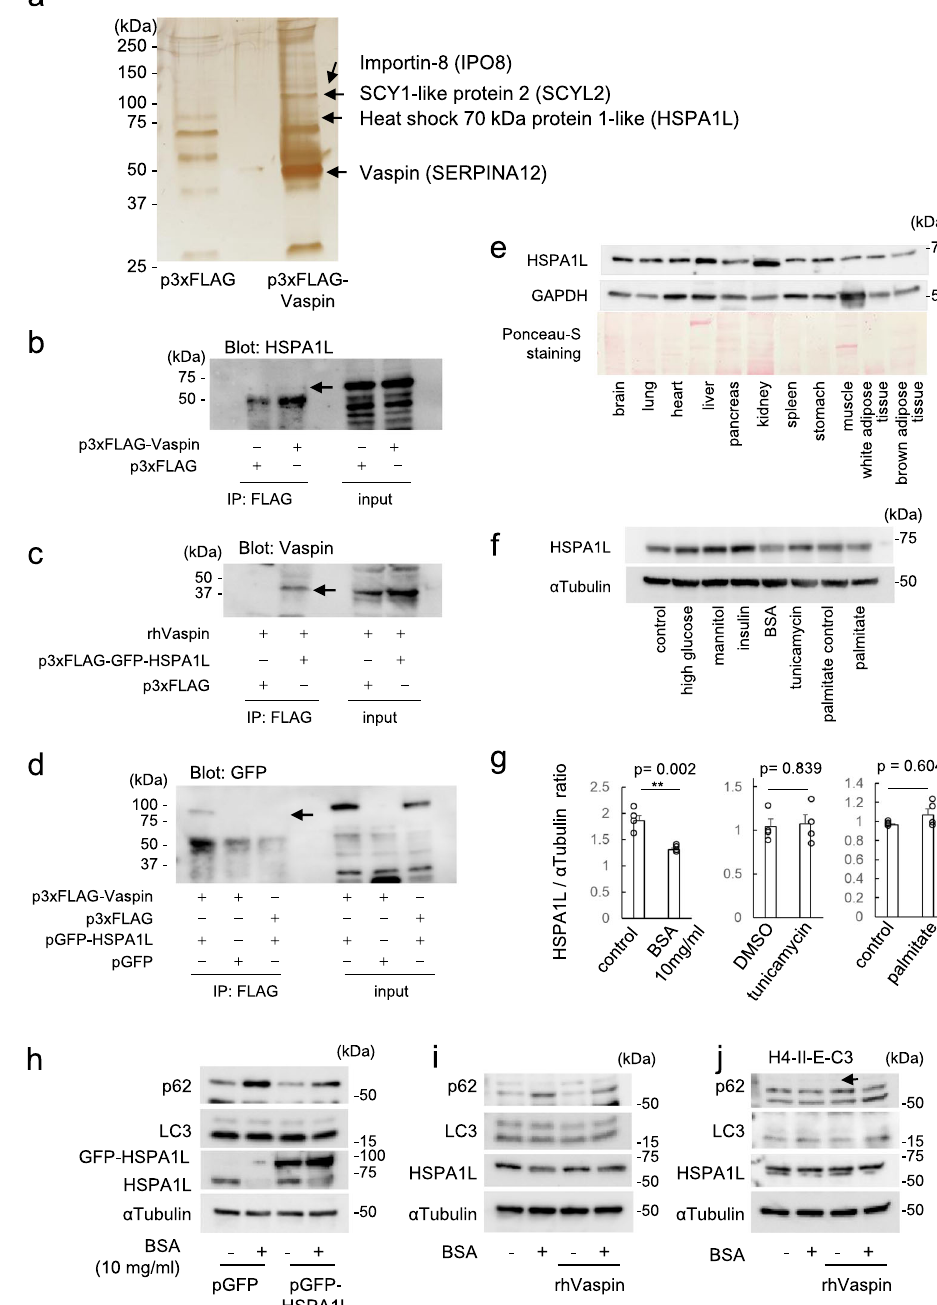
Enlarged lysosomes of proximal tubular cells in humans with obesity and diabetes mellitus . In human renal biopsy samples from diabetic nephropathy patients, enlarged lysosomes were visible by immuno fl uorescence staining of lamp1 (Supplementary Fig. S9a – c), while a patient with thin basement membrane disease (TBMD) as a nondiabetic and non-obese control demonstrated lamp1-positive lysosome as small dots (Supplementary Fig. S9d). In an overweight patient with TBMD of body mass index (BMI) 26.7 kg/m 2 , lamp1 positive vacuole were observed in proximal tubules (Supplementary Fig. S9e). In diabetic nephropathy (DN) or obesity related kidney disease, lamp1 positive enlarged vacuoles were clearly visible, indicating enlarged lysosomes (Supplementary Fig. S9a – c,